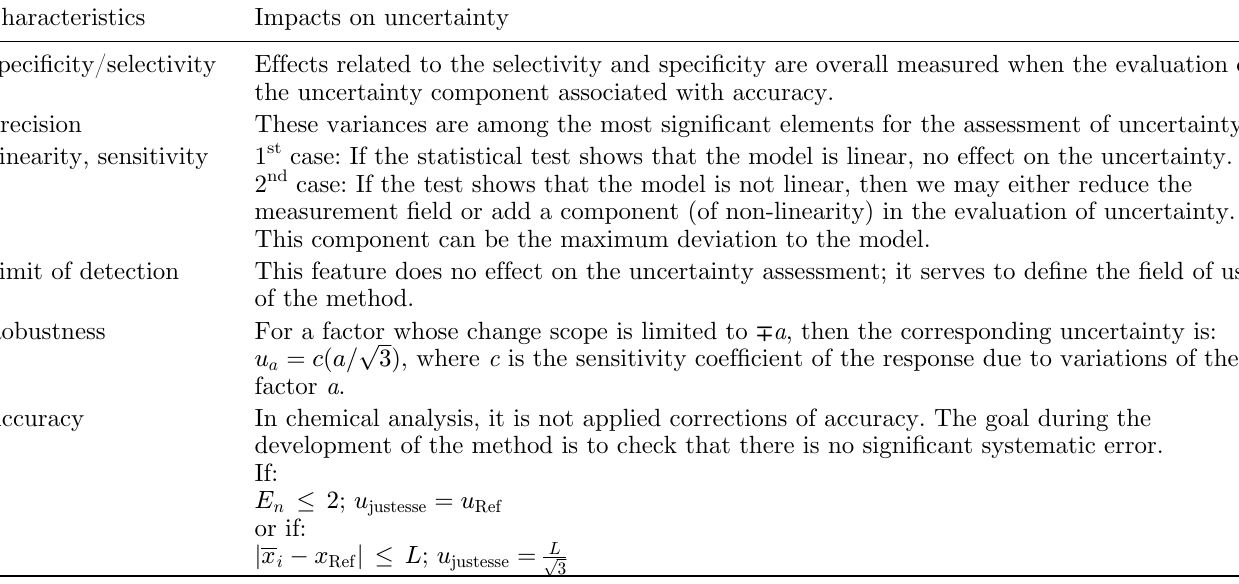
Table 11. Impacts of characteristics on